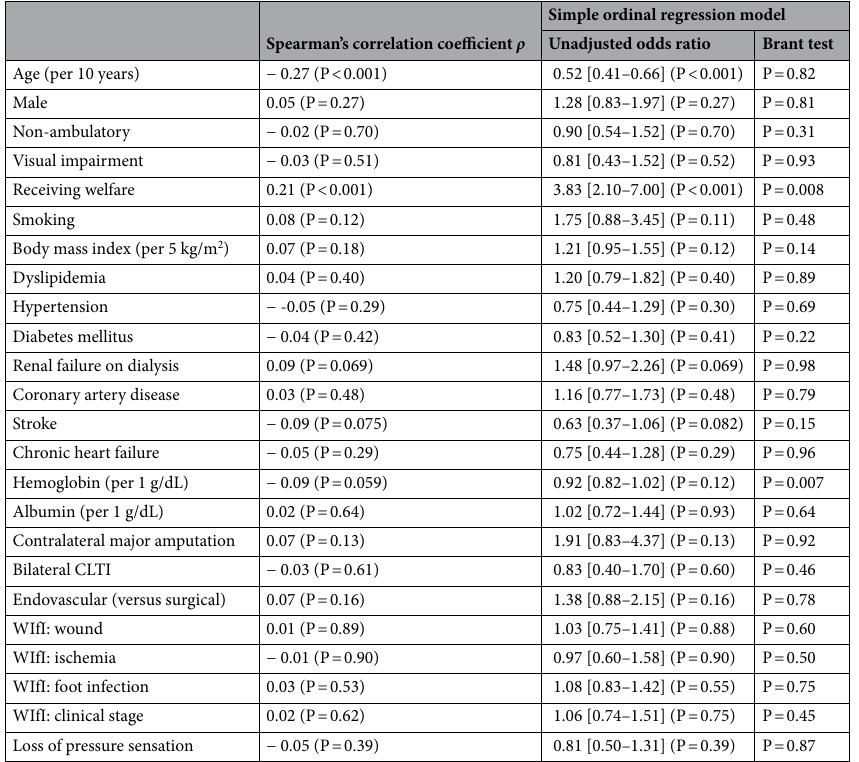
Table 5. Crude association of clinical characteristics with lower frequency of hospital visitation by a trusted family member or friend in the overall study population ( n = 413). Odds ratios, derived from the ordinal regression analysis, are presented together with 95% confidence intervals. CLTI chronic limb-threatening ischemia, WIfI wound, ischemia, and foot infection.